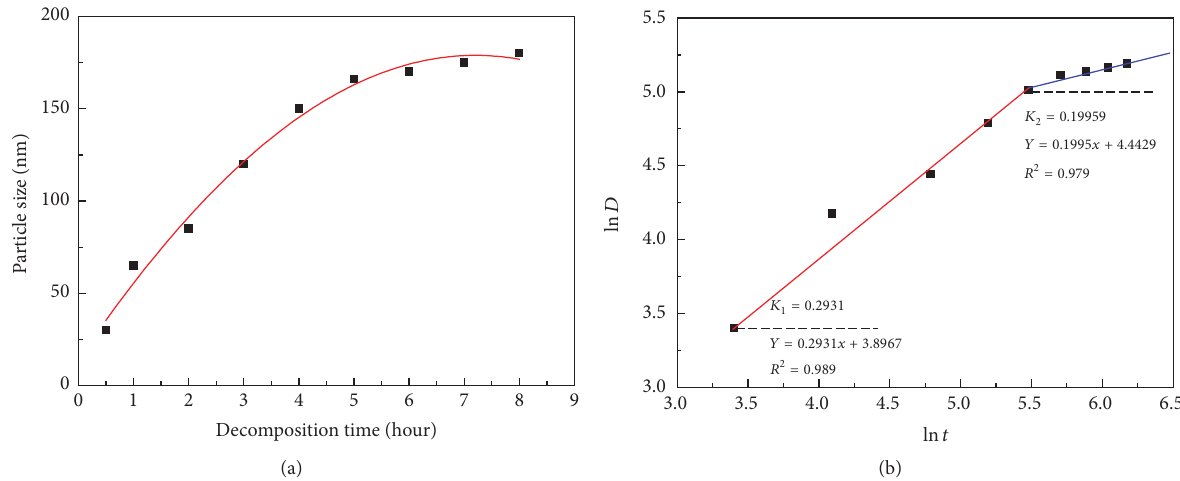
Figure 10: Different heat retaining times (450 ∘ C) for precursor sample (a) decomposition: (a) particle size for Co; (b) kinetics model for growth of Co.